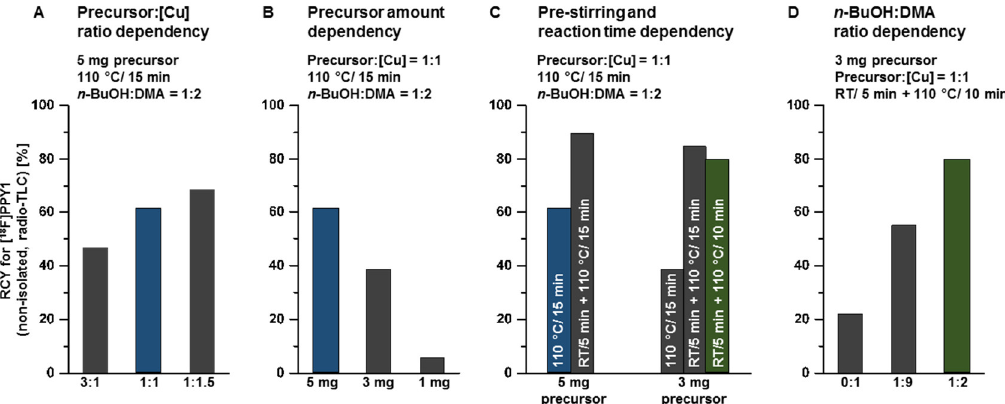
Figure 5. Investigated reaction conditions for the radiosynthesis of [ 18 F] PPY1 : ( A ) ratio of precursor 6 -to-copper catalyst, ( B ) amount of precursor 6 and ( C ) with/without pre-stirring of [ 18 F]TBAF with [Cu] for 5 min at RT and reaction time dependency, ( D ) ratio of n -BuOH-to-DMA.